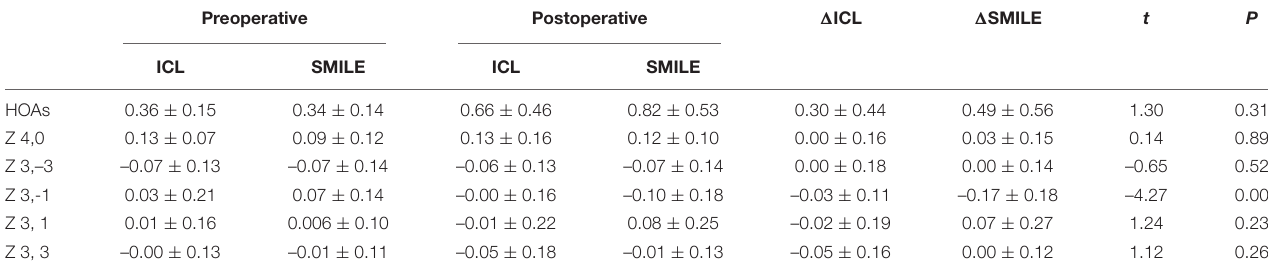
TABLE 3 | Induced changes in aberrations before and after surgery.